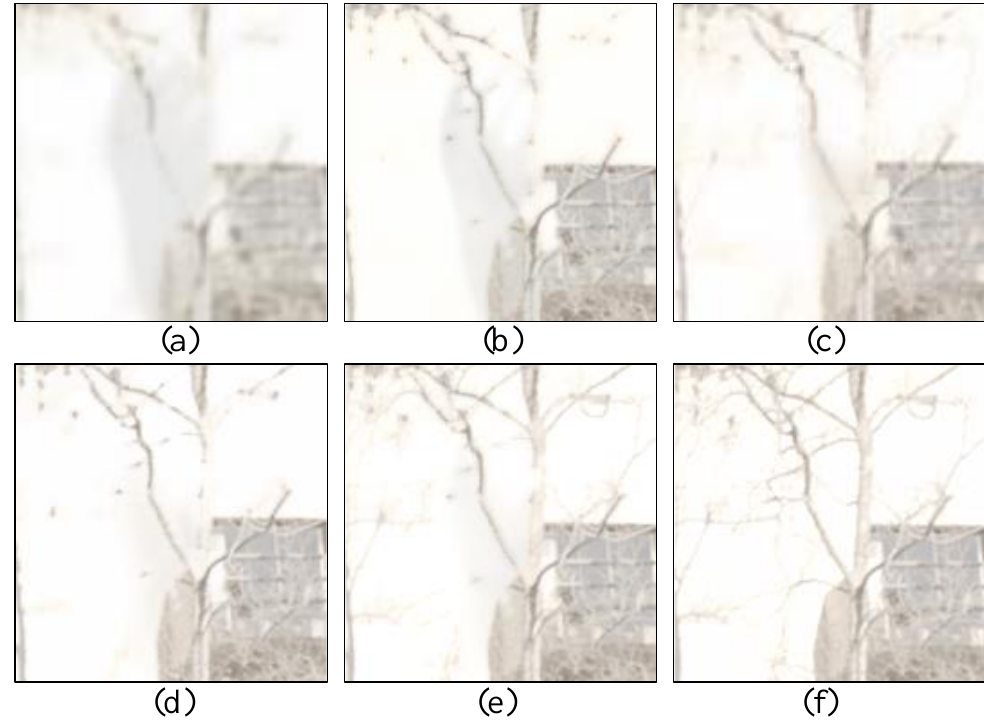
Figure 6. Comparison of the fused results from different network structures with ( a ) no attention module, ( b ) only correlation attention, ( c ) only motion attention, ( d ) correlation + motion + warp, and ( e ) correlation + motion + attention. The last image ( f ) represents the ground truth. The zoomed-in patches are shown to make a better comparison.